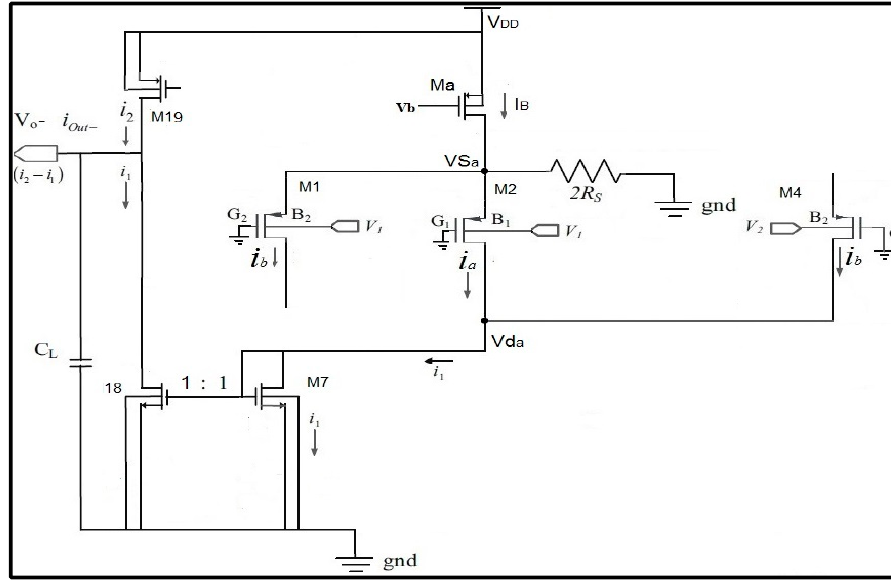
Figure 7. Half circuit of the proposed OTA.